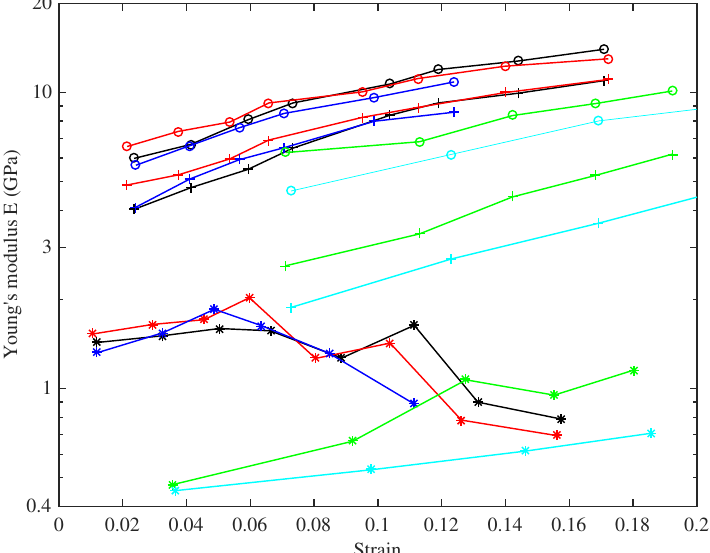
Figure 7. Young’s modulus at the base temperature of 20 ◦ C plotted against the strain, measured by three approaches: E B from bending sti ff ness (o), E T from modulation of string tension ( + ) and E S from the slope of the long-term stress-strain plot (*). Colours identify the di ff erent tested strings (Table 1): black (8:A6), red (14:A5), blue (5:A4), green (23a:A3), cyan